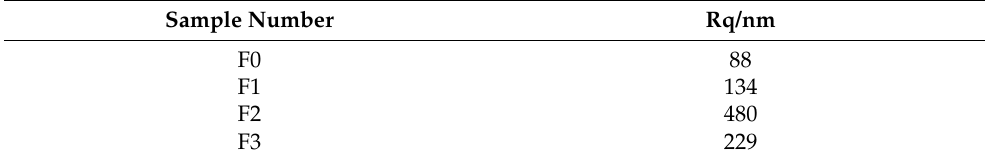
Table 1. Modified sample surface roughness.